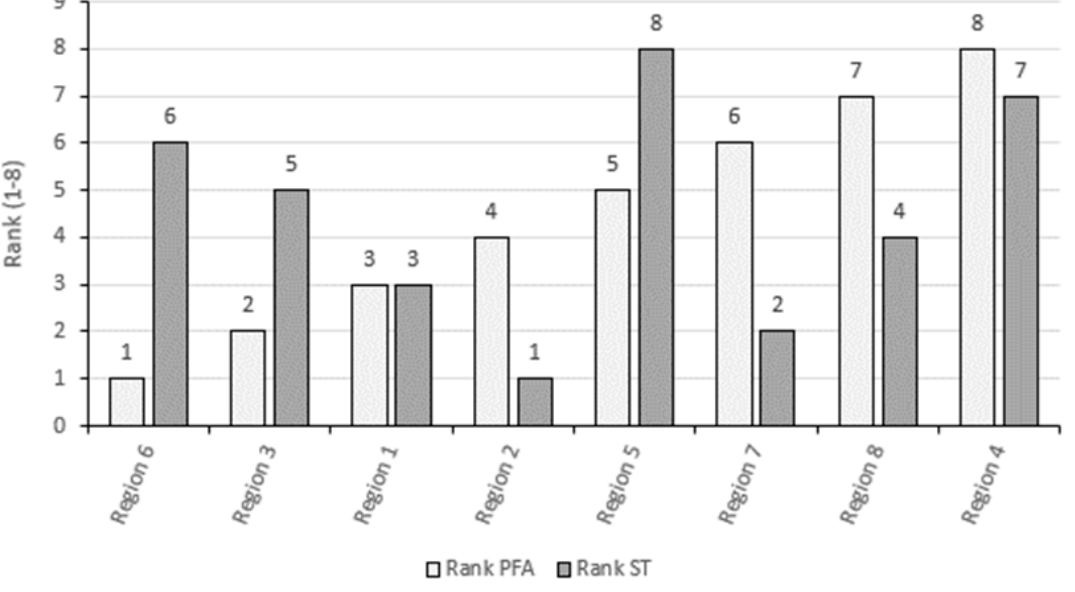
Figure 5. The ranking of the eight regions from rank 1 (highest) to 8 (lowest) for the total biomass of spawning females in 2019 (spawning target, ST) or the number of salmon and trout merged pre-fishery abundance (PFA) in the same year.